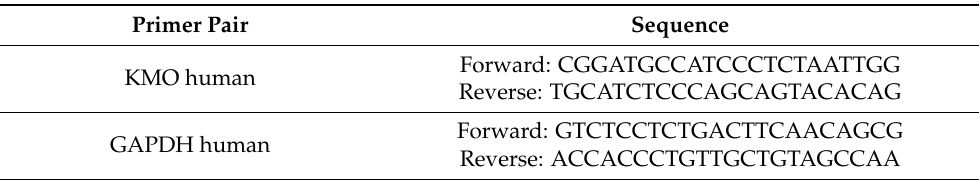
Table 2. Forward and reverse sequences of KMO and GAPDH primer pairs used for quantitative real-rime RT-qPCR. Primer Pair Sequence Forward: CGGATGCCATCCCTCTAATTGG KMO human Reverse: TGCATCTCCCAGCAGTACACAG Forward: GTCTCCTCTGACTTCAACAGCG GAPDH human Reverse: